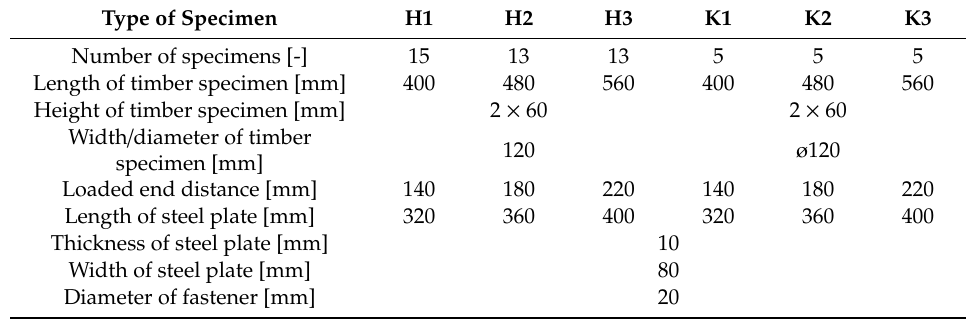
Table 1. Dimensions of all specimen types for tension tests parallel to the grain.